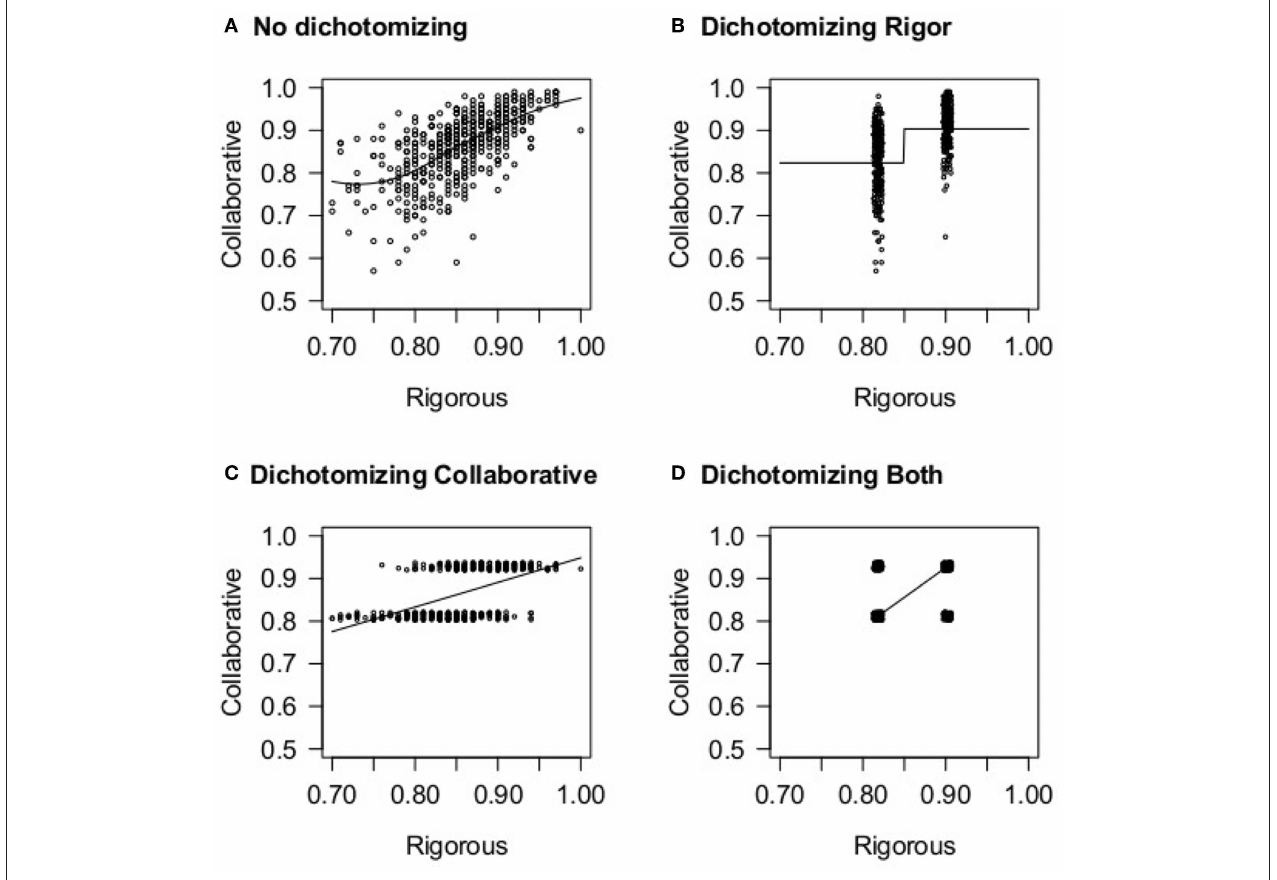
FIGURE 1 | Data from New York City schools on the relationship between collaborative and rigorous ratings. (A) Shows the original variables. (B–D) Dichotomize the variables thereby presenting less information. A slight random “jitter” has been added to the values of dichotomized variables so that it can be seen when multiple schools have similar values.